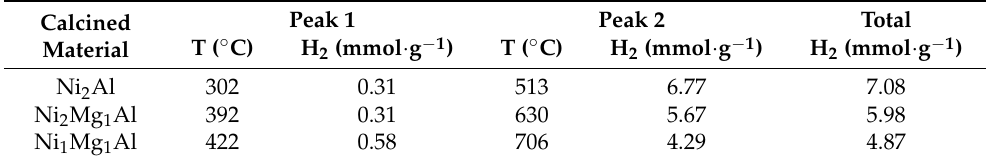
Figure 5. H 2 -TPR of the LDH precursors calcined at 400 ◦ C for 4 h. Table 4. Specific hydrogen consumption during the TPR of the LDH precursors calcined at 400 ◦ C